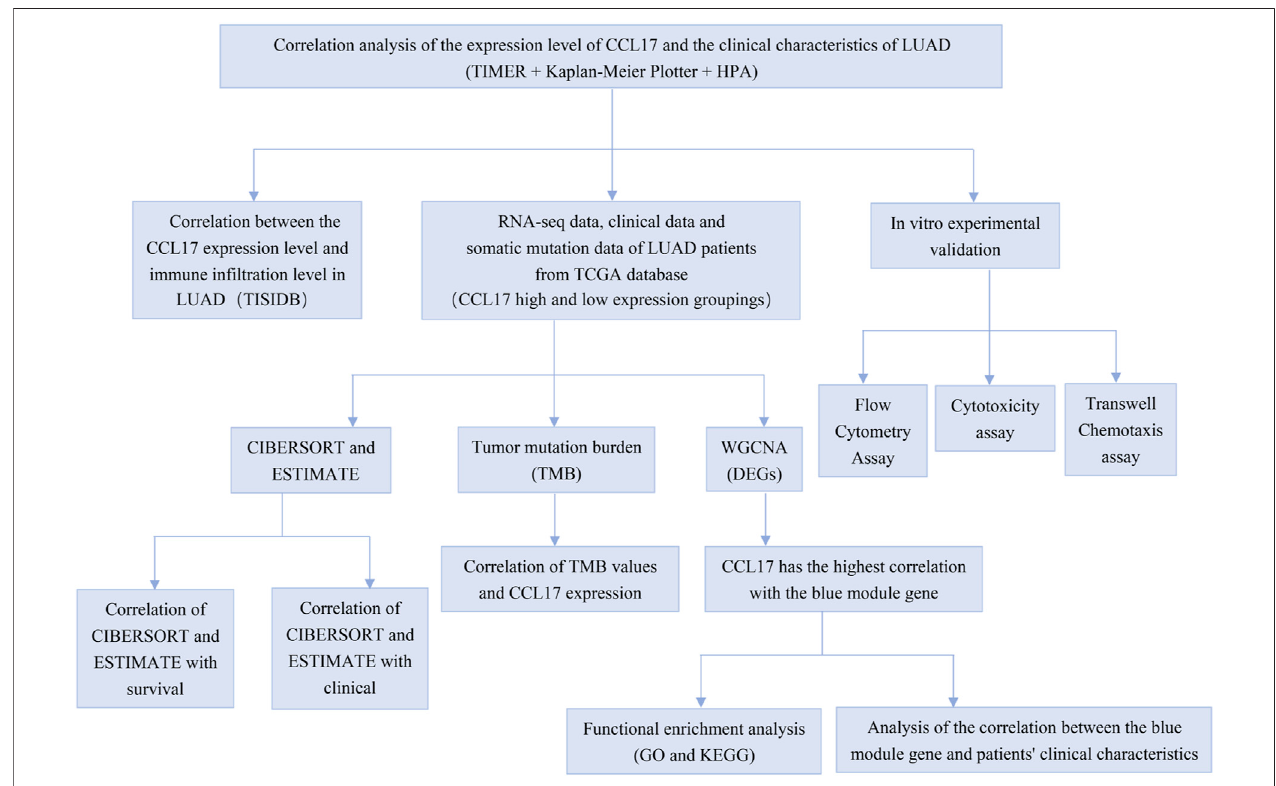
FIGURE 1 | Flow chart for whole process analysis of